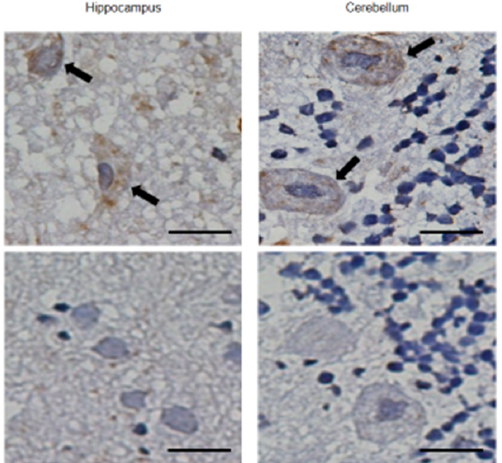
Figure 1. Delivery of pabinafusp alfa to neuronal cells in the brain of a cynomolgus monkey. Pabinafusp alfa was intravenously administered to cynomolgus monkey at a dose of 5 mg/kg, and their brains were resected at 8 h after the administration. Arrows in upper panels indicate pyramidal cells in the hippocampus (left) and Purkinje cells in the cerebellum (right). Lower panels show negative control (administered control was IgG, which does not cross the BBB). Scale bars, 20 mm. Updated from [11].